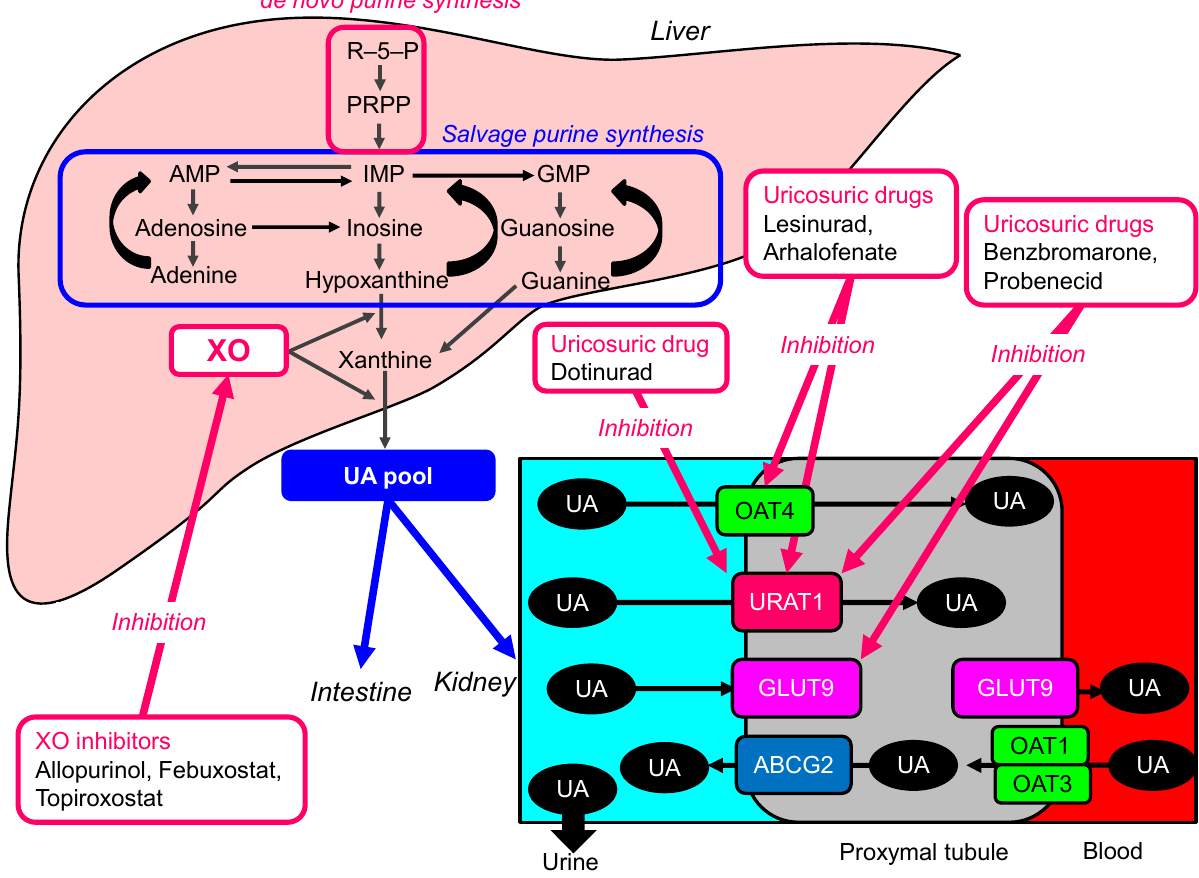
Figure 3. The pharmacological action points of UA lowering treatments. AMP, adenosine monophosphate; GMP, guanine monophosphate; GLUT9, glucose transporter 9; IMP, inosine monophosphate; OAT4, organic anion transporter 4; PRPP, phosphor-ribosyl-pyrophosphate; PRS, phosphor-ribosyl-pyrophosphate synthetase; UA, uric acid; URAT1, urate transporter 1; XO, xanthine